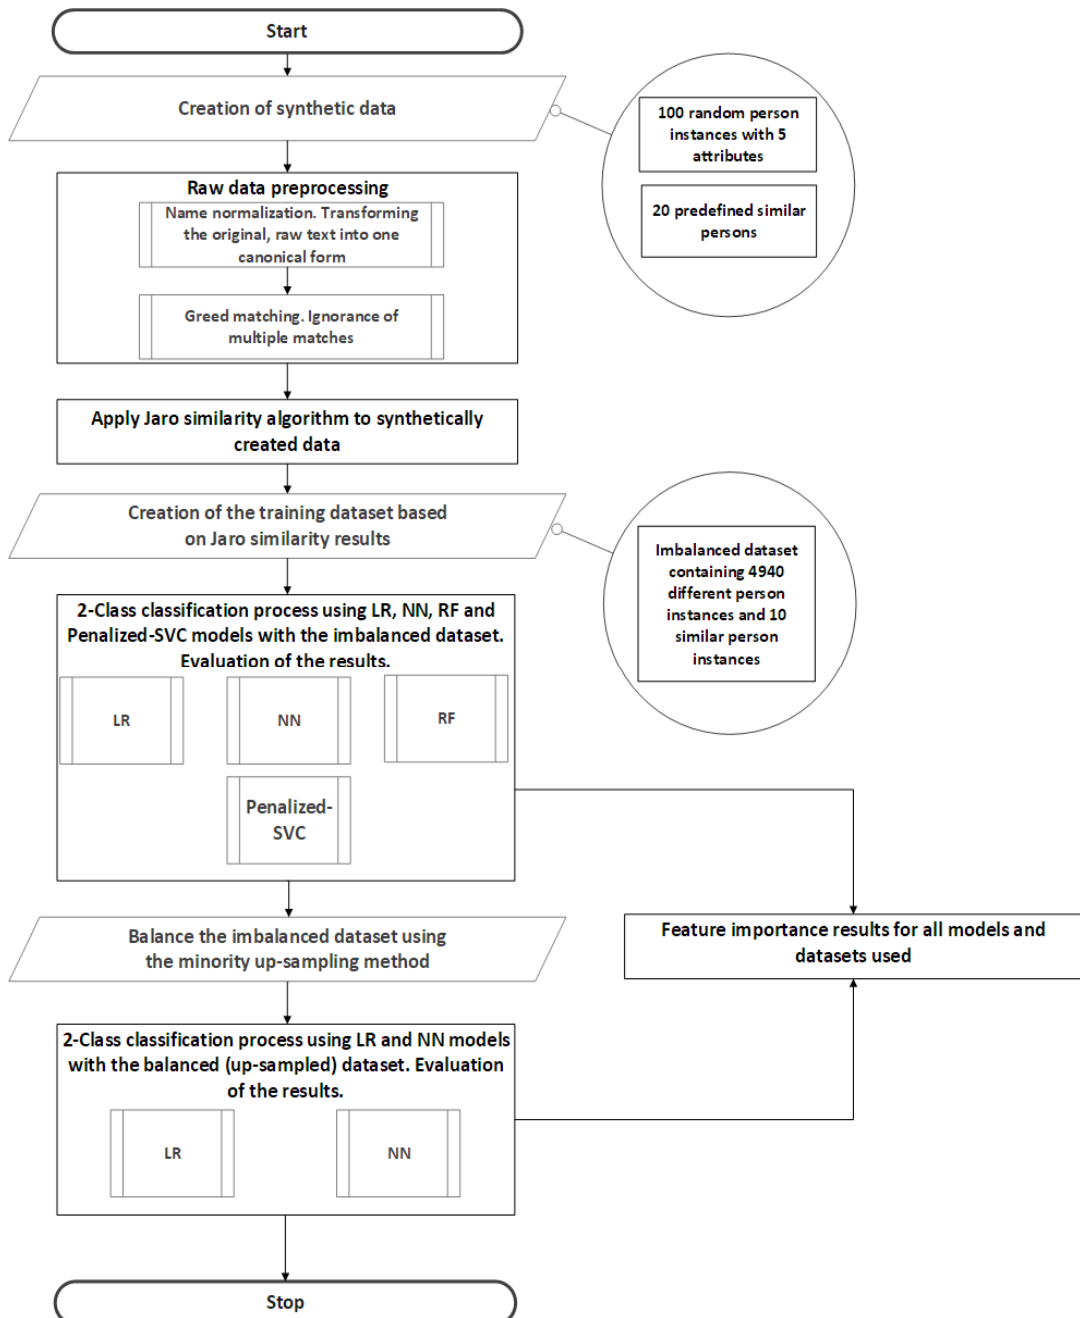
Figure 2. Methodology steps taken for this study.